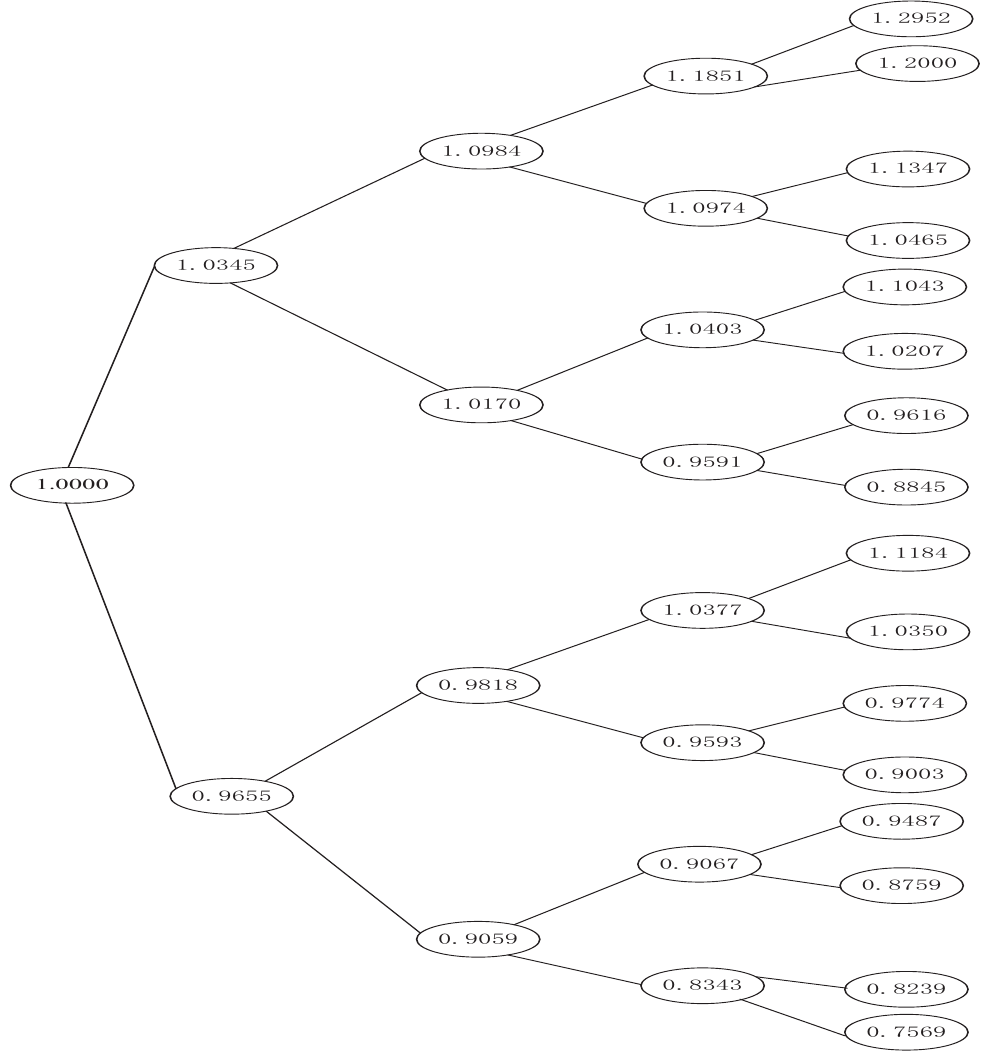
Figure 1. A four-step Hermite binomial tree with arbitrage, H = 0.75 and k =